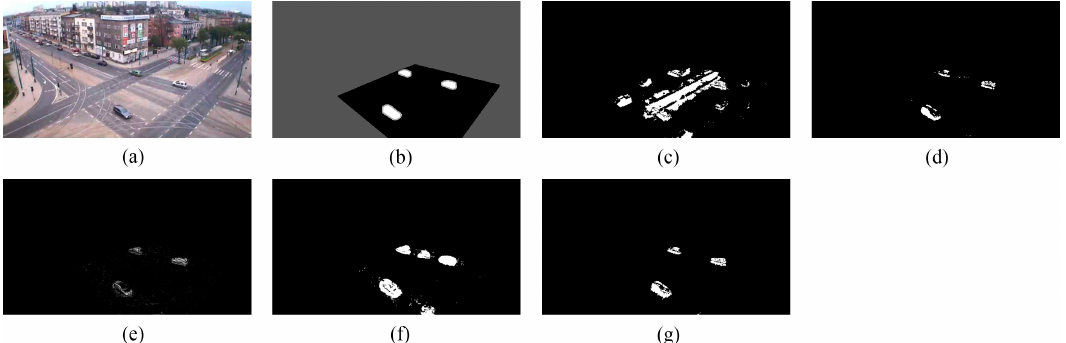
Figure 10. Detection results of the 90th frame of TC96 (Frame 502): ( a ) input frame; ( b ) ground-truth reference; ( c ) result of ViBe; ( d ) result of PCP; ( e ) result of TD-2DDFT; ( f ) result of TD-2DUWT; ( g ) result of TD-3DDWT.